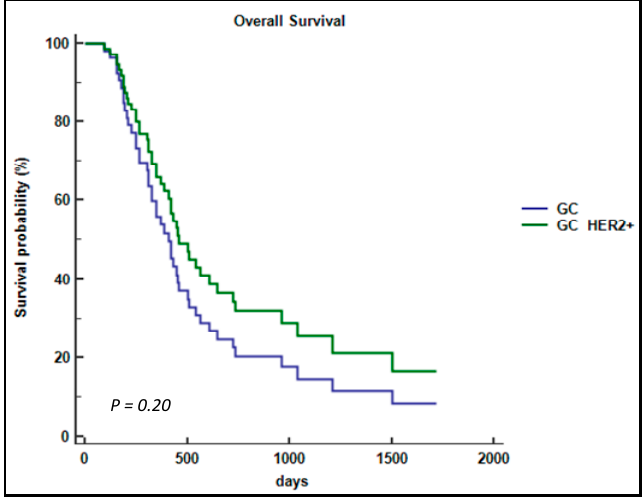
Figure 2. Cox regression for overall survival (OS) analysis for the mGC patient subgroup based on the HER2 -expression.